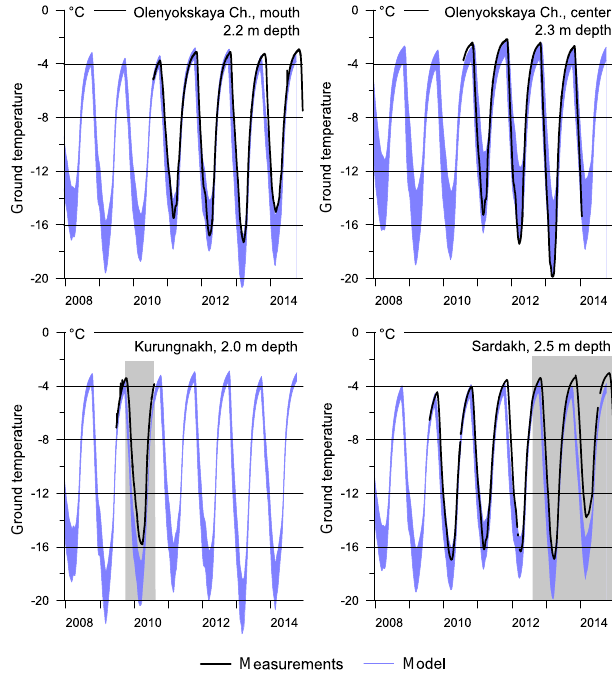
Figure 7. Modeled and measured ground temperatures at depths of 2.0–2.5m at four locations in the LRD. The blue area de- picts the spread between model runs with snow densities of 200 and 250kgm − 3 . Periods for which in situ data are affected by thermokarst are marked in grey. These should not be used for com- parison, see text.